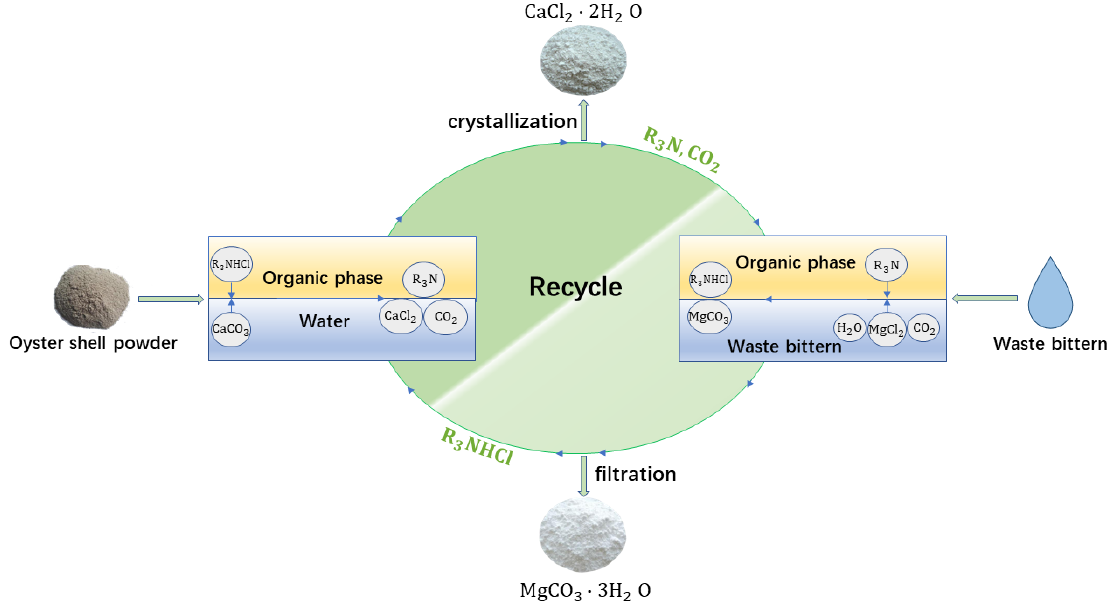
Figure 1. The process flow diagram of production of magnesium carbonate and calcium chloride from oyster shell and waste bittern. from oyster shell and waste bittern.